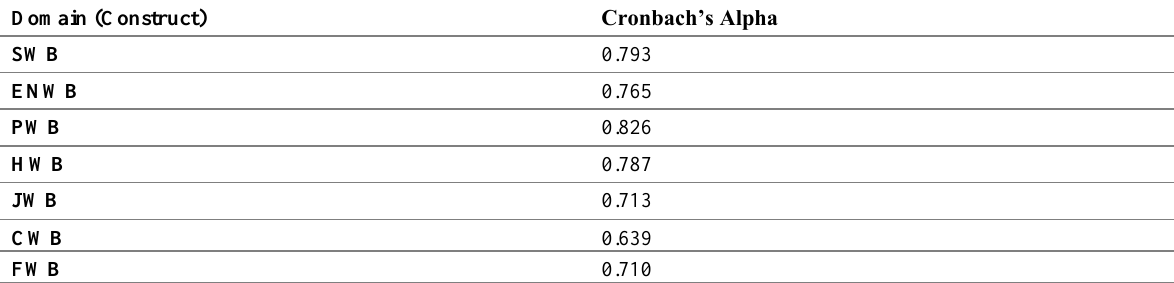
Table 2: Cronbach’s Alpha for All Well-Being Dimensions